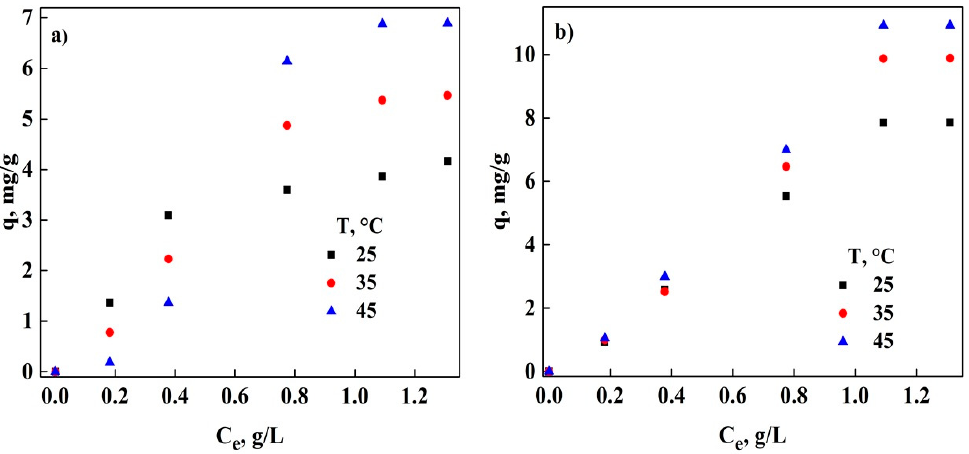
Figure 1. Evolution of DNS adsorption at different temperatures; ( a ) GAC and ( b ) PAC.